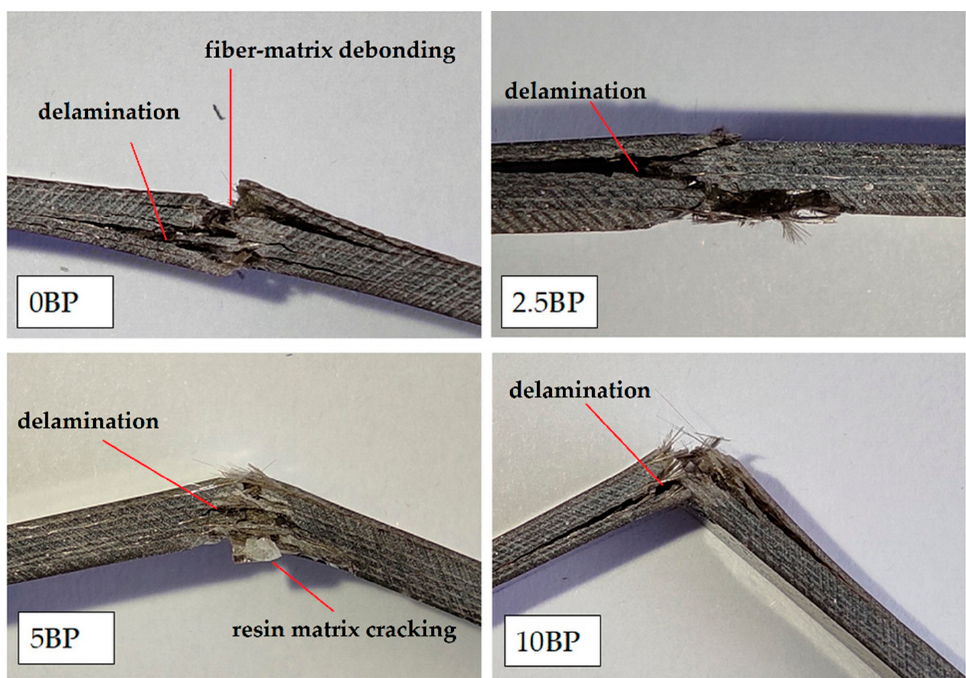
Figure 3. Images of the damaged area of composites modified with basalt powder after the impact test.